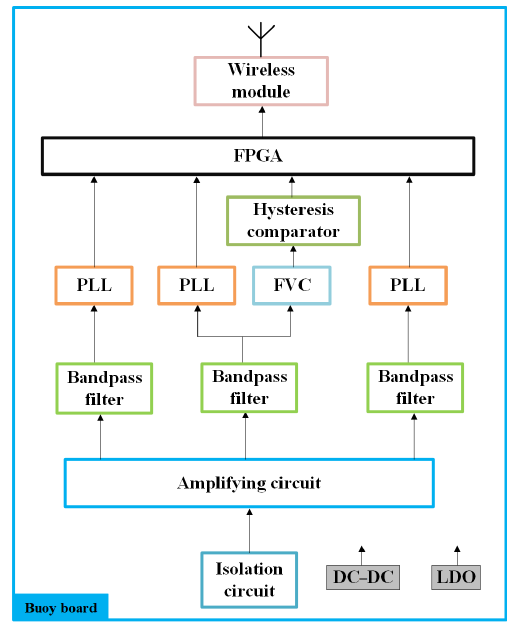
Figure 5. Block diagram of the buoy board